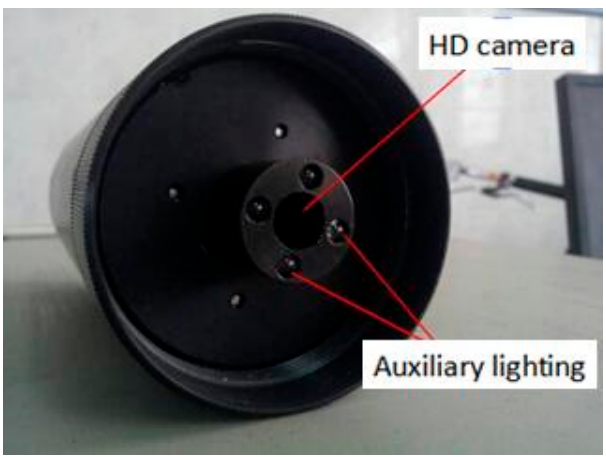
Figure 3. Picture of high-definition camera.